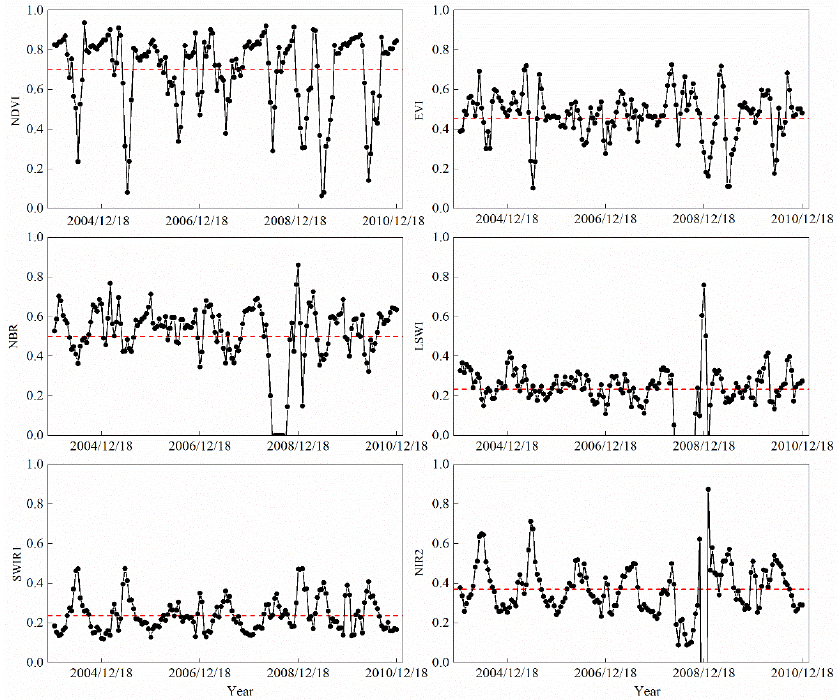
Figure 3. Temporal variations in NDVI, EVI, LSWI, NBR, and NIR/SWIR bands based on the selected samples (pixels) during 2004 – 2010.